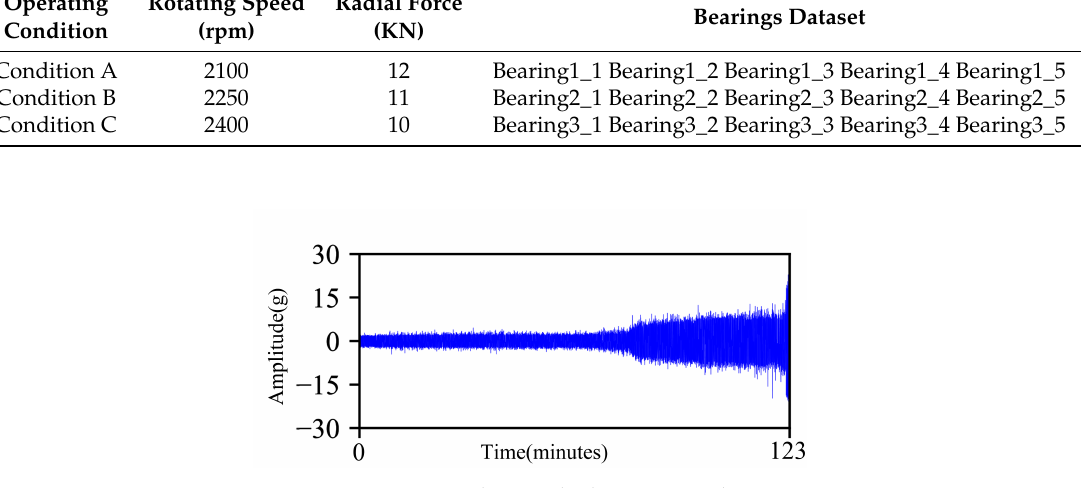
Figure 6. Typical vertical vibration signals.